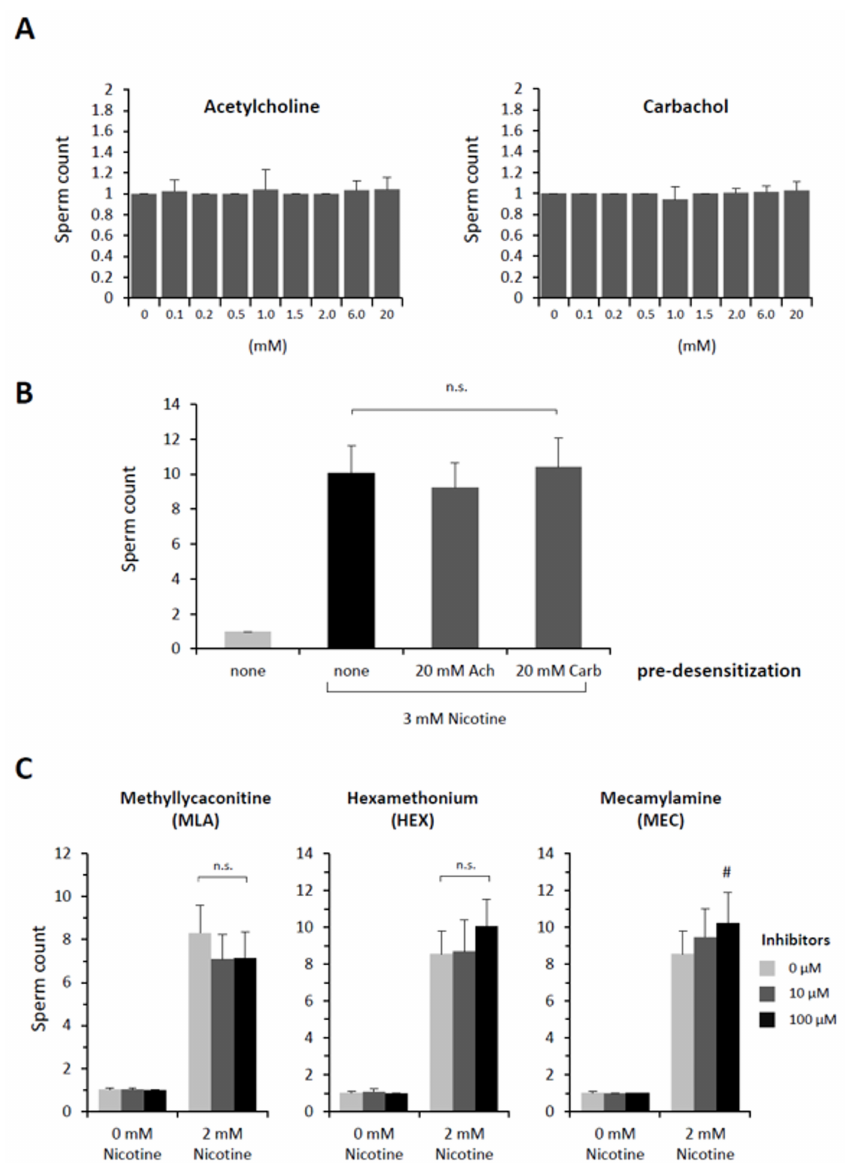
Figure 2. Acetylcholine receptors are not involved in nicotine-induced polyspermy in P. lividus . ( A ) Prior to fertilization, eggs were pretreated with either acetylcholine (ACh) or carbachol at the same range of concentration (80 to 150 eggs for a given concentration) and for the same incubation time (5 min) as in the nicotine experiments in Figure 1. The number of Hoechst 33342-prestained sperm incorporated into the egg was counted. ( B ) P. lividus eggs (n = 40 for each condition) were desensitized by excess amount of acetylcholine (ACh) or carbachol (Carb) for 5 min prior to exposure to 3 mM ( − ) nicotine (5 min). The egg-incorporated sperm were counted 10 min after fertilization. One-way ANOVA: n.s. (di ff erences statistically non-significant). ( C ) Eggs were pretreated with various inhibitors of ACh receptors 5 min before the addition of nicotine (2 mM) or NSW. Five minutes later, eggs were fertilized (n = 40 for each condition), and the number of egg-incorporated sperm were counted. # Significantly di ff erent from the eggs pretreated with 2 mM nicotine without the inhibitor: Tukey HSD test, # P <